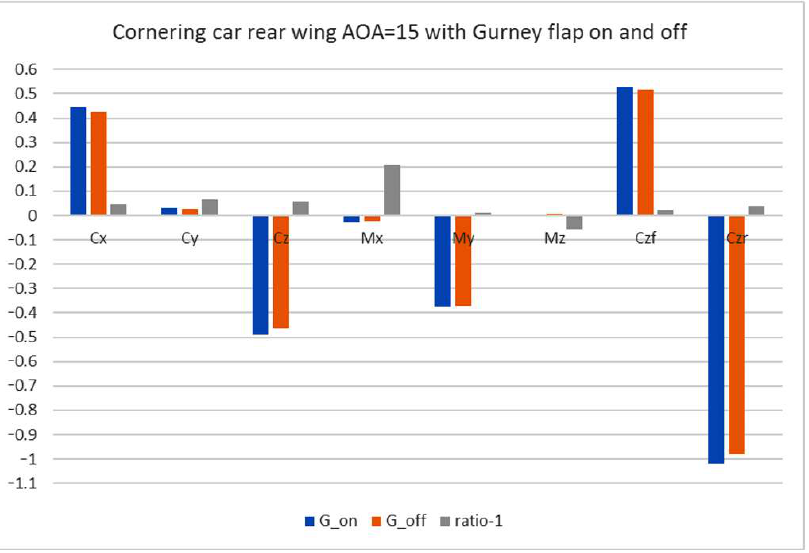
Figure 28. Influence of the state of the Gurney flap on aerodynamic characteristics of cornering car.